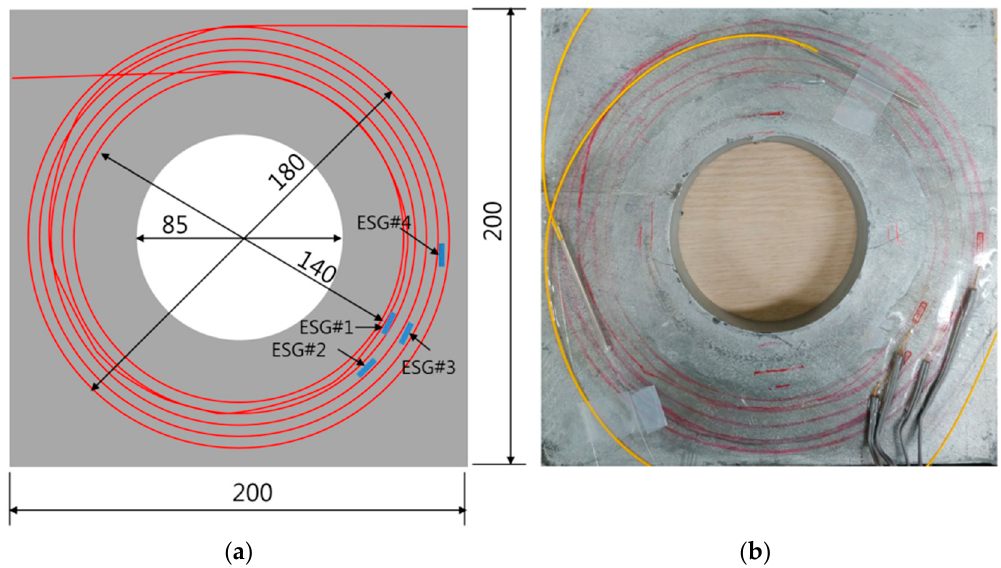
Figure 3. The bearing plate with a sensing optical fiber and four electrical strain gauges. ( a ) Conceptual drawing ( b ) Photograph.